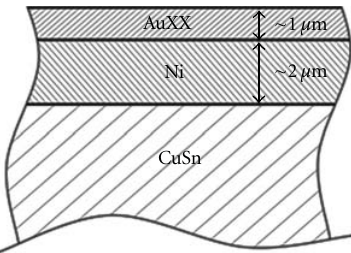
Figure 18: Cross-section of plating system of electric contacts before the wear and fretting corrosion test.